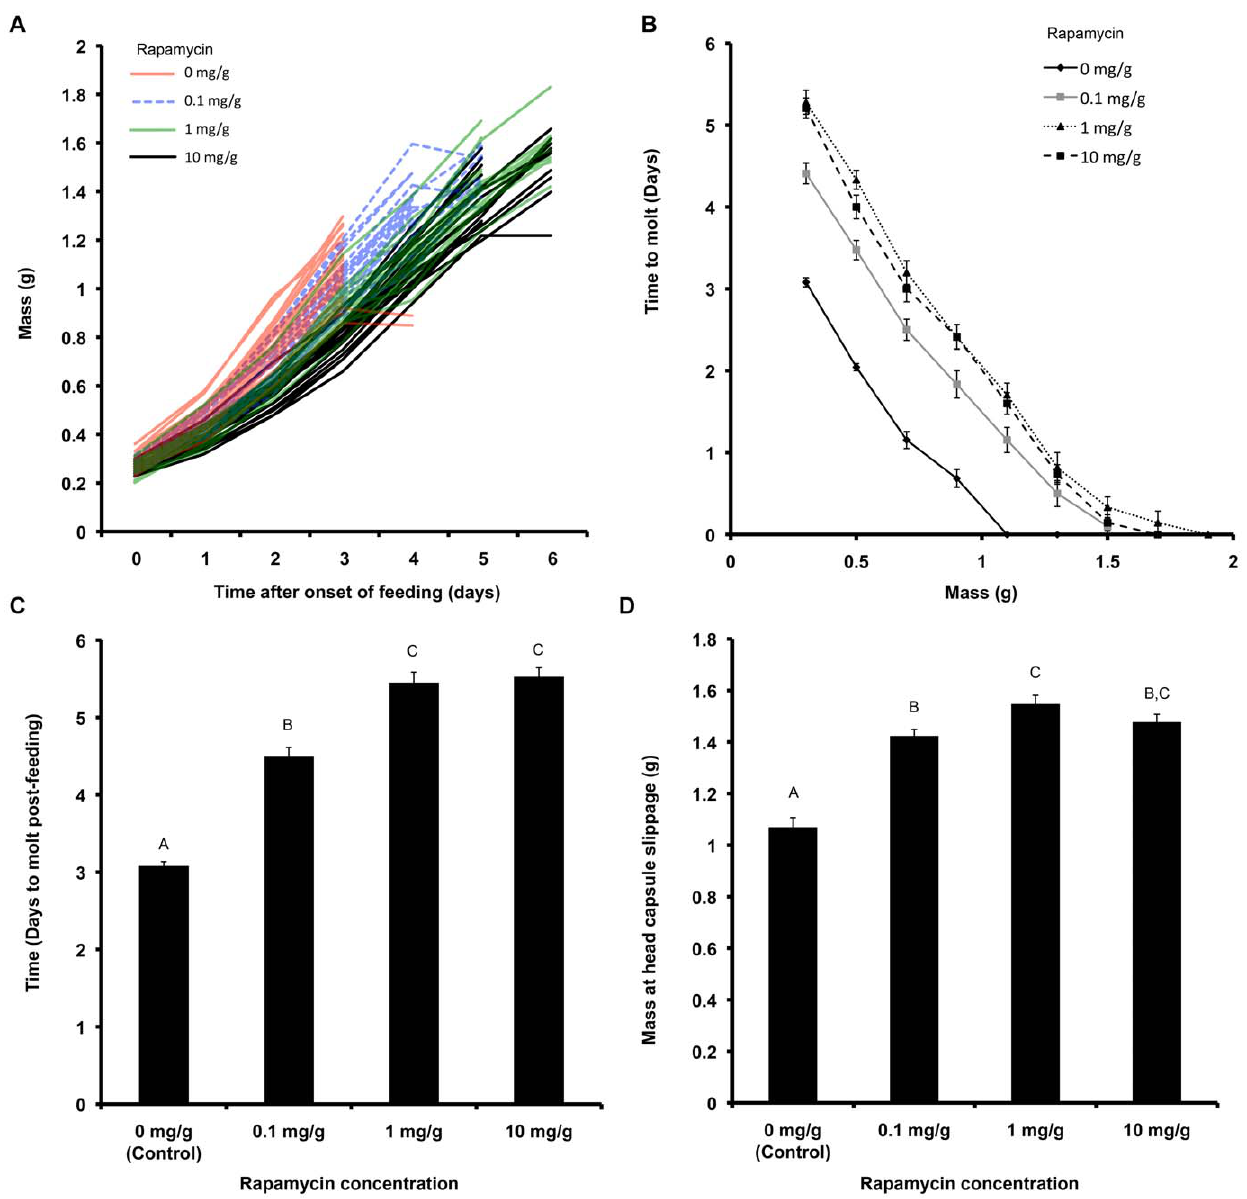
Figure 3. Effect of rapamycin on larval molt and time to molt. (A) Growth trajectories of larvae fed different concentrations of rapamycin. Differently colored lines represent different concentrations of rapamycin. (B) Time taken for larvae at various body sizes to initiate a molt. (C) Total time taken for larvae to initiate a molt. Different letters represent statistically significant differences (ANOVA with Tukey-Kramer HSD test; p , 0.0001). All pairwise comparisons are significantly different from each other (p , 0.0001) except between those treated with 1 mg/g and 10 mg/g rapamycin (p=0.961). (D) Final body size at time of head capsule slip (n=19–24 for each treatment). Different letters represent statistically significant differences (ANOVA with Tukey-Kramer HSD test; p , 0.0001). All rapamycin fed larvae molted at a significantly larger size relative to the DMSO treated control larvae (p , 0.0001). Larvae fed 1 mg/g rapamycin molted at a significantly larger size compared to those fed with 0.1 mg/g rapamycin (p=0.0171). Error bars represent standard